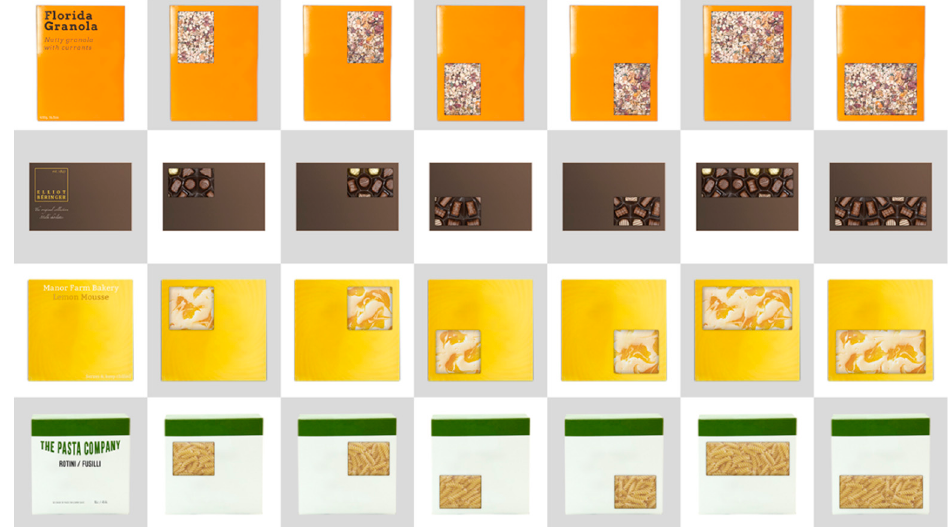
Figure 1. The experimental stimuli shown to participants. The four categories of product (granola, chocolates, lemon mousse, and pasta) are shown with the six possible window positions and sizes (4 quarter- and 2 half-window positions).